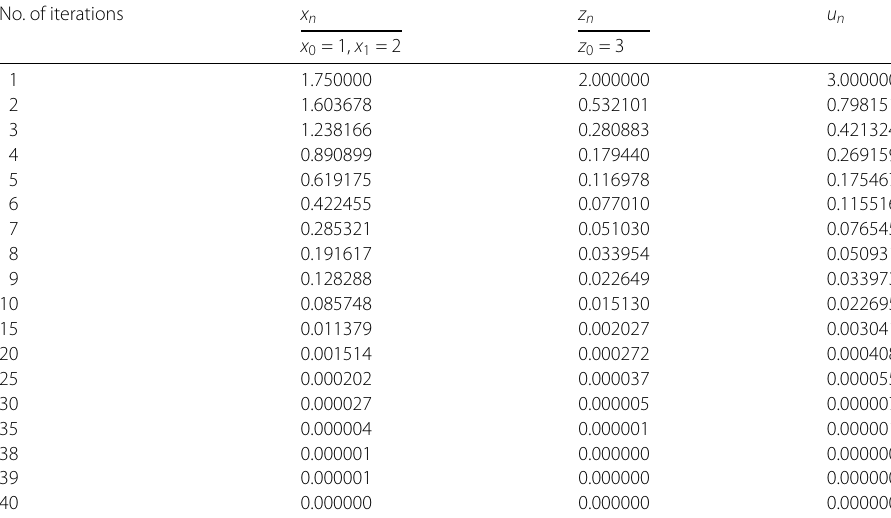
Table 1 Values of x n , z n and u